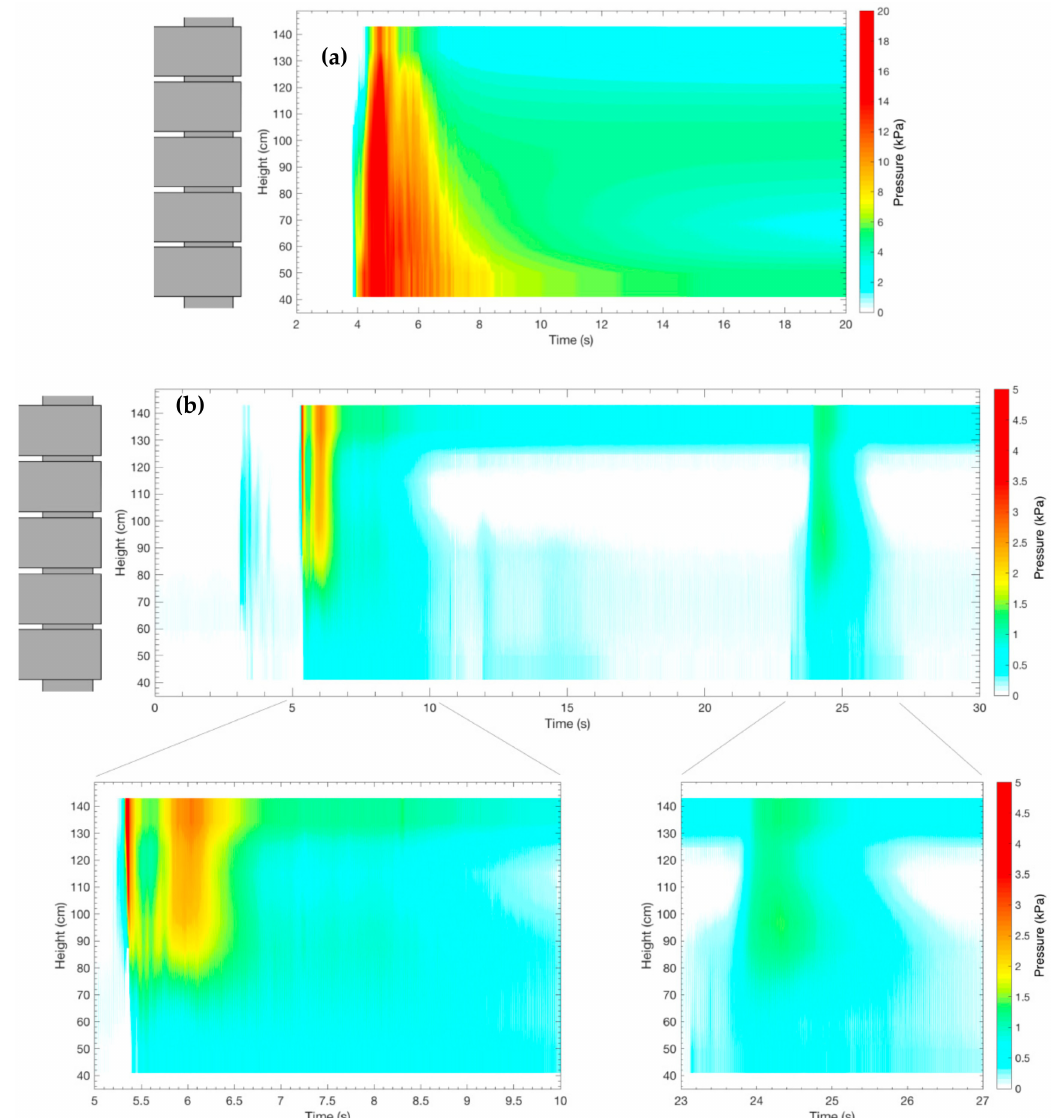
Figure 17. Pressure distribution for the ( a ) 17 April 2013 and ( b ) 20 January 2014 avalanches (data averaged over 0.2